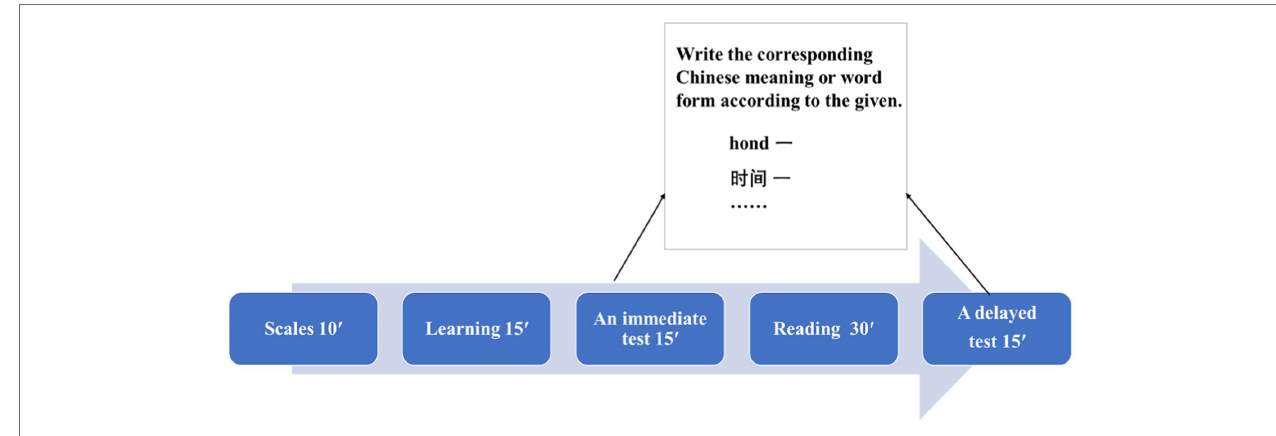
FIGURE 1 | Diagram of the experiment process and the test task.